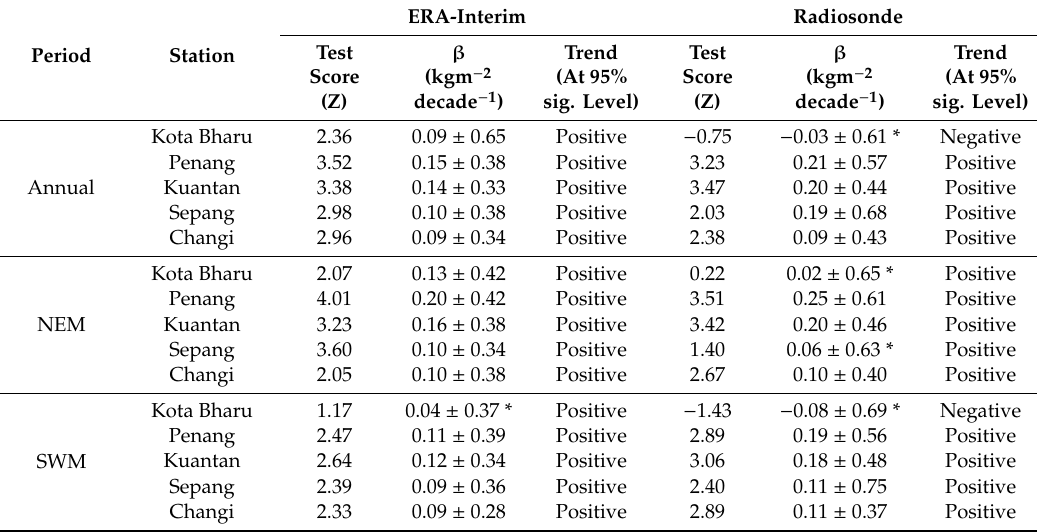
Table 3. Decadal trend estimates in ERA-Interim and Radiosonde IWV over five synoptic stations for the annual, northeast monsoon (NEM) and southwest monsoon (SWM) time scales (Unit: kgm − 2 Decade − 1 ). Z scores and trend direction are also